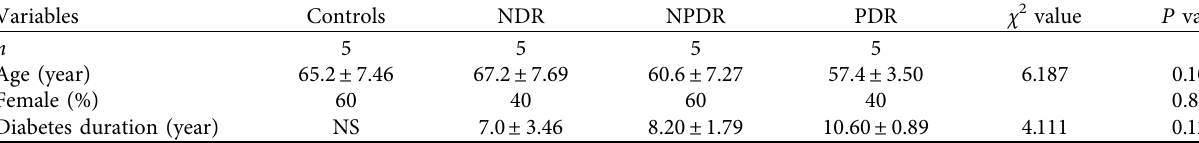
Table 1: Clinical characteristics of the participants.